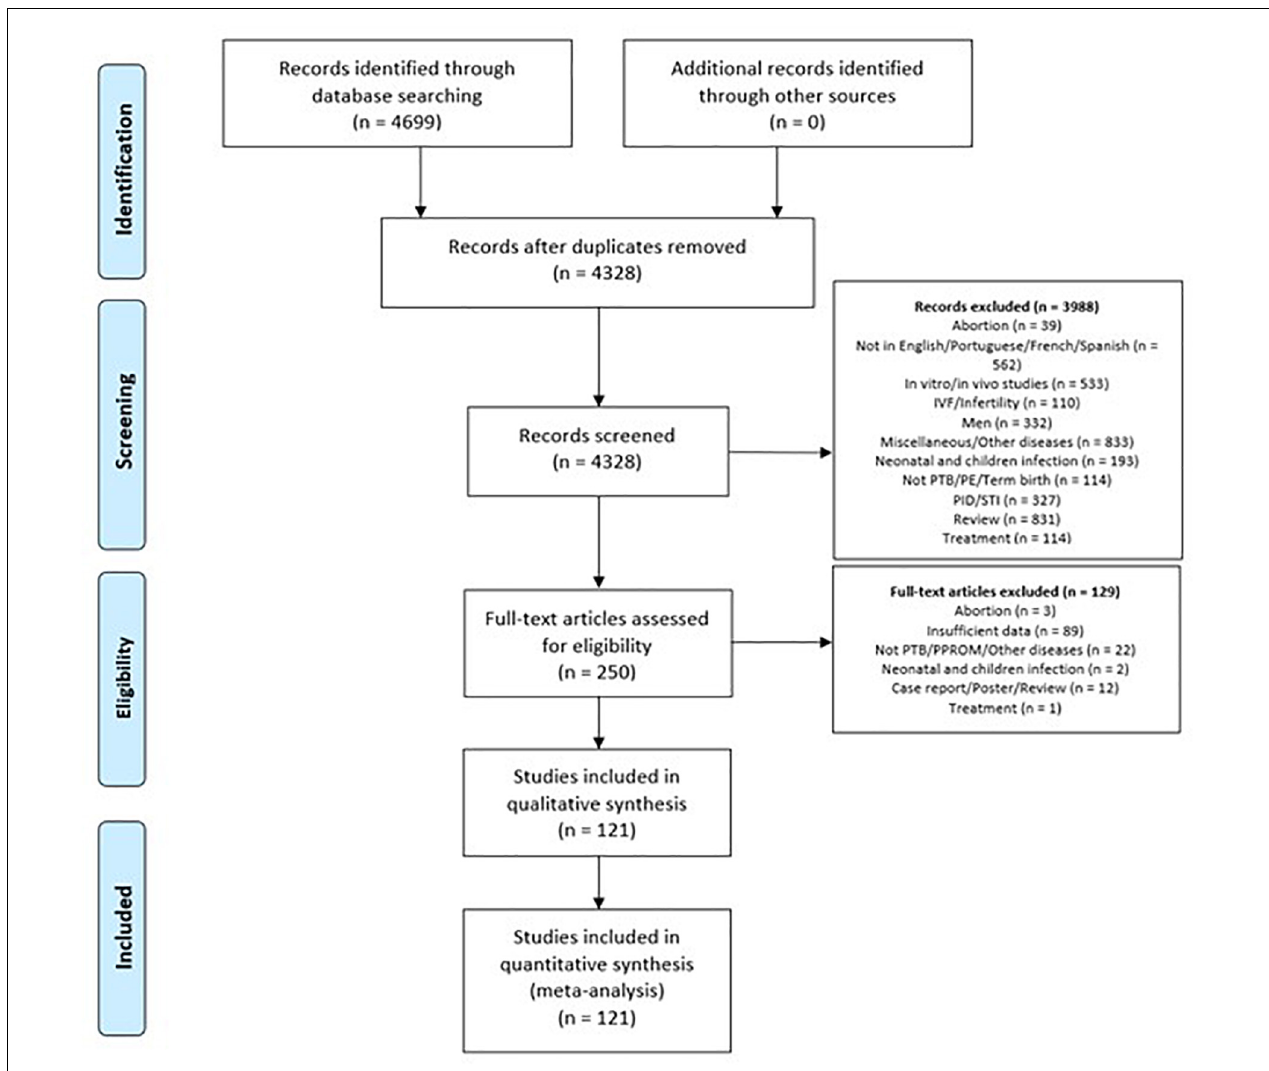
FIGURE 1 | Preferred reporting items for systematic reviews and meta-analyses flow